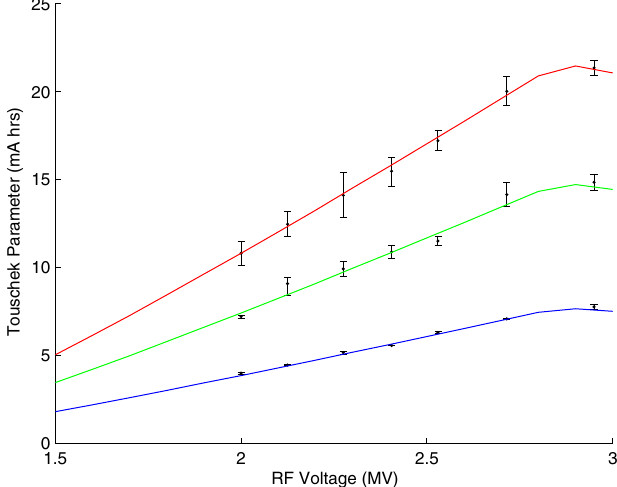
FIG. 12. Measured Touschek parameter at different rf voltages for three coupling settings, 0.1%, uncorrected (0.06%) and minimal (0.01%). Colored lines are best fit coupling values based on the Touschek equation. Error bars indicate uncertainty in the Touschek parameter from the decay curve fits. Fitted emittance ratio values are 0.0916% (red), 0.043% (green), and 0.0116%